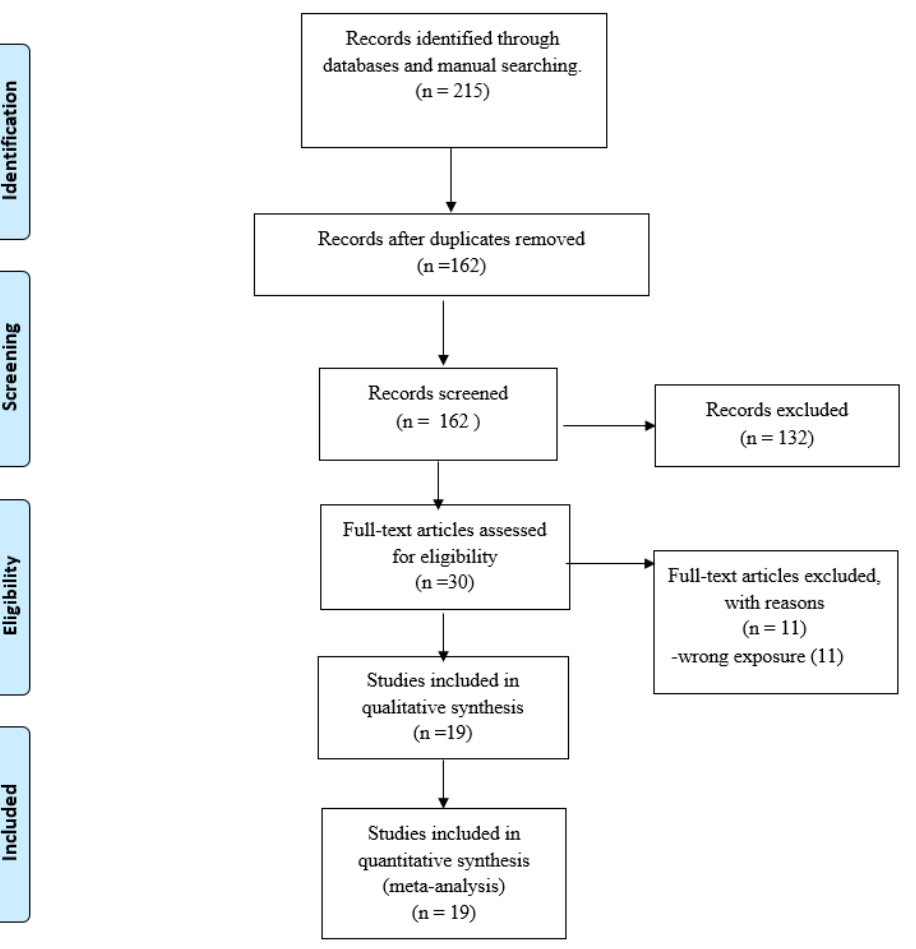
Figure 1. PRISMA Flow Diagram.